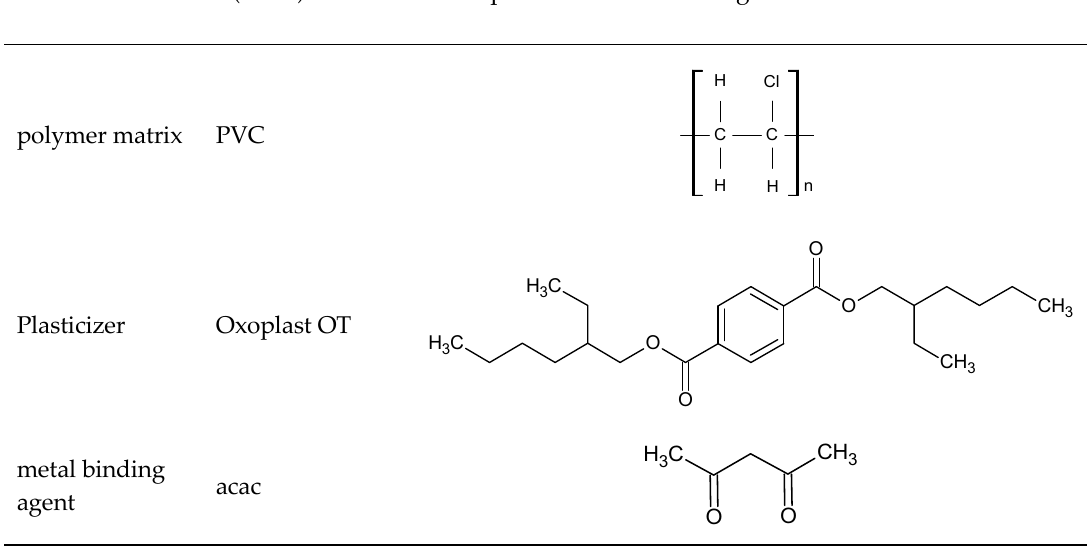
Figure 1. Main components of PVC-based polymer composites promoted with acac: polyvinyl chloride (PVC), bis(2-ethylhexyl) terephthalate (Oxoplast OT) and acetylacetone (acac).